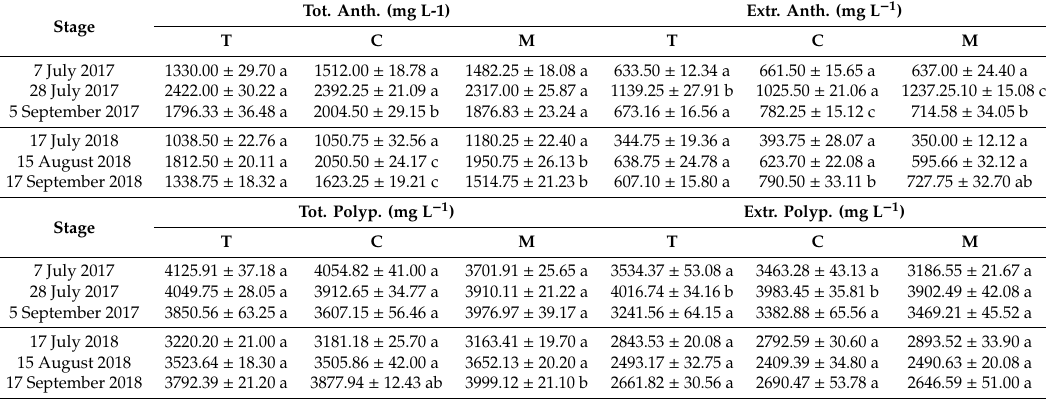
Table 3. Phenolic maturity. Total anthocyanin (Tot. Anth.), extractable anthocyanin (Extr. Anth.), total polyphenol (Tot. Polyp.), and extractable polyphenol (Extr. Polyp.) contents of V. vinifera treated with tillage (T), cover cropping (C), and mulching (M), during two seasons (2017-2018). Measurements were conducted at three times: full veraison (7 July 2017 and 17 July 2018), mid maturation (28 July 2017 and 15 August 2018), and full maturation (5 September 2017 and 17 September 2018). Data (mean ± SE, n = 10) were subjected to one-way ANOVA. Di ff erent letters within the same parameter and row indicate significant di ff erences among treatments (LSD test, p ≤